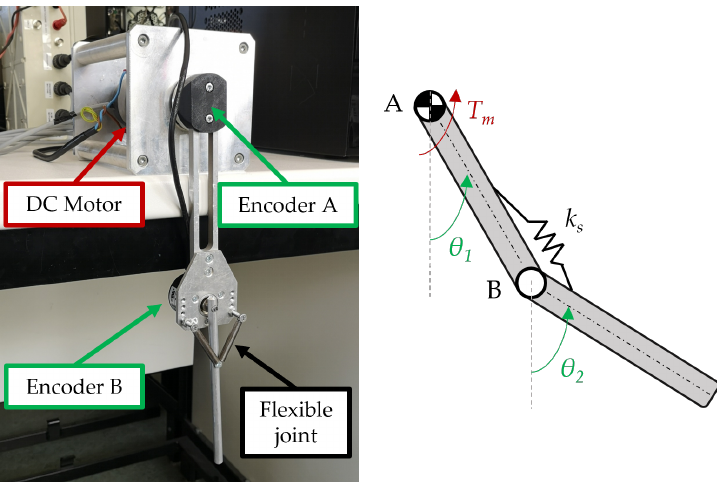
Figure 2. The two-link flexible robot arm and its kinematic scheme.